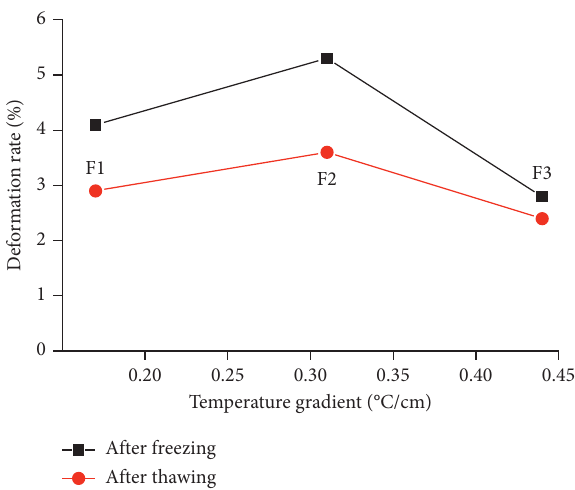
Figure 6: Deformation rates of the expansive soil columns after freezing and thawing